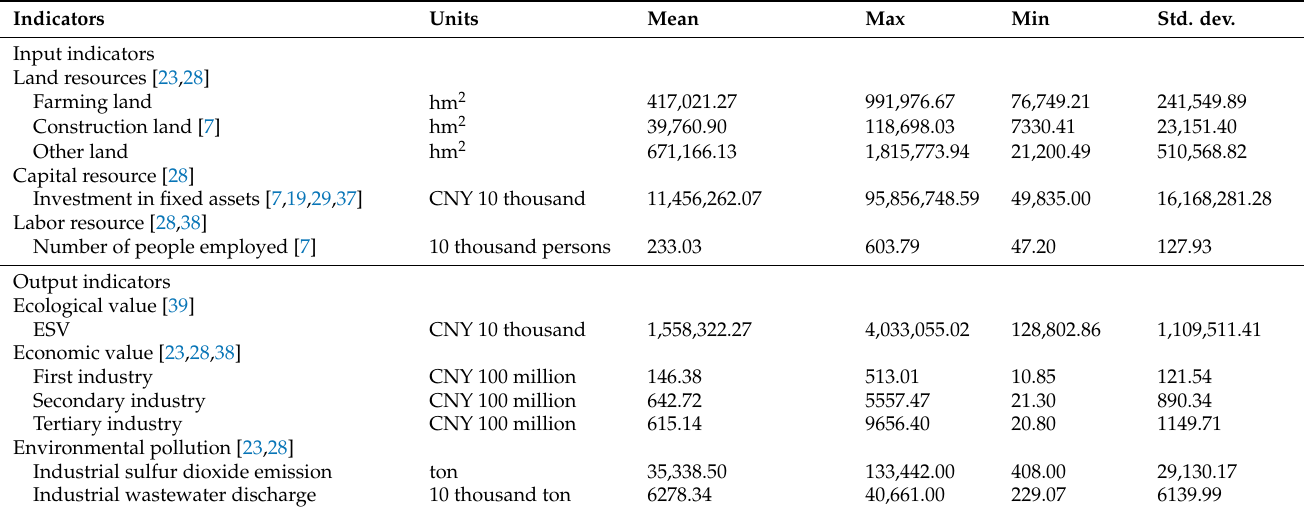
Table 2. Index selection of input and